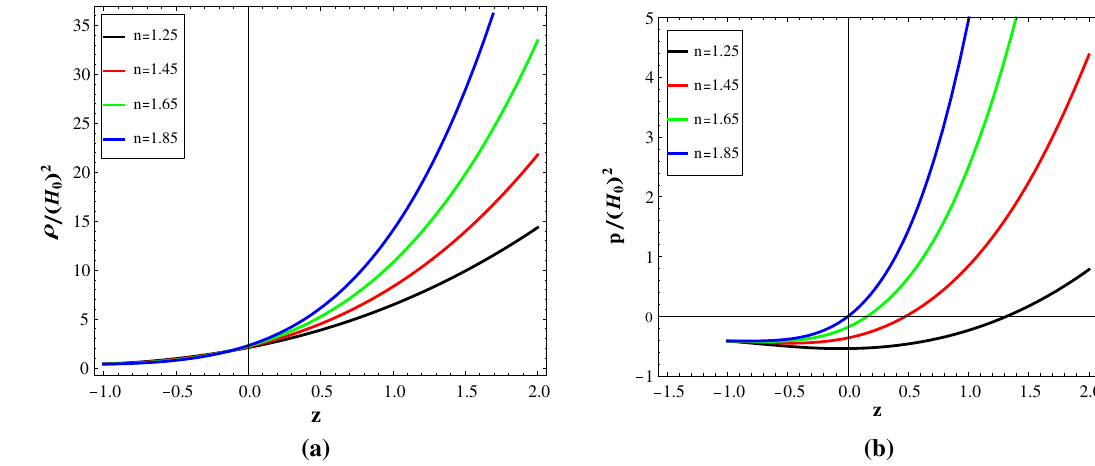
Fig. 3 The plots of the energy density ρ and pressure p vs. redshift z with λ = − 130